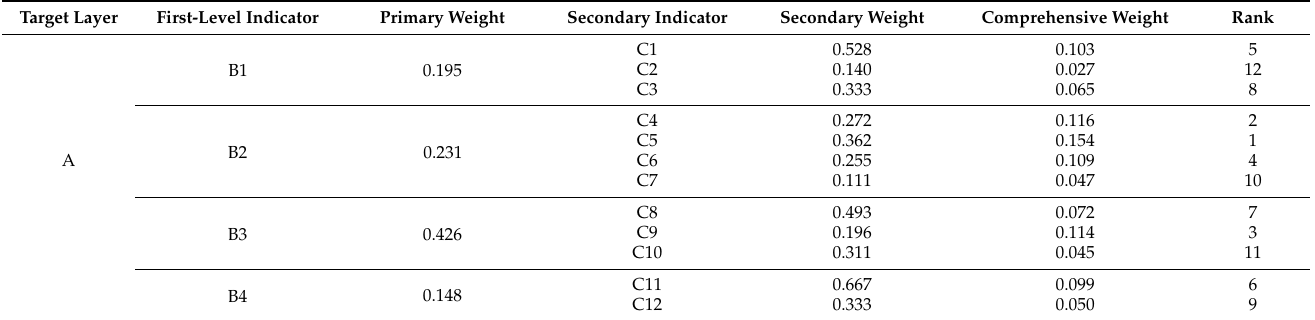
Table 14. Total hierarchical ranking of highway bridge construction safety risk evaluation